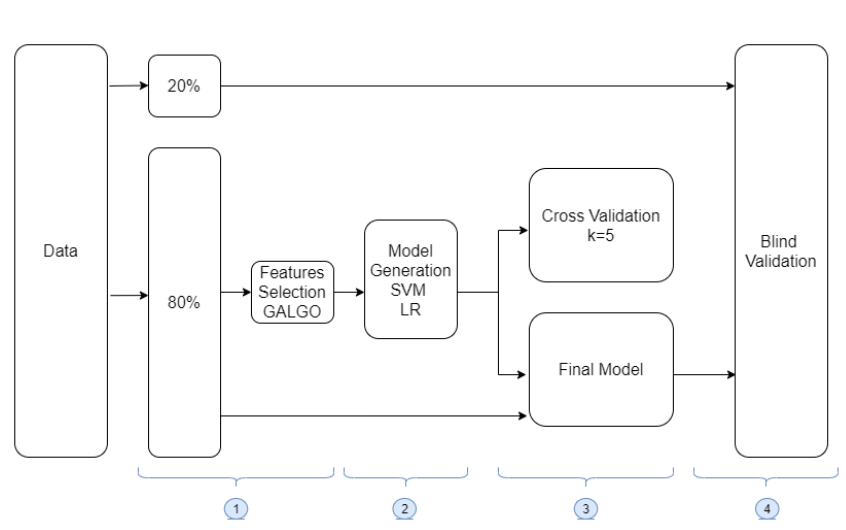
Figure 1. Flow chart representing the process of features selection, machine learning models gen- eration (by Logistic Regression and Support Vector Machine), and validation (cross-validation and blind